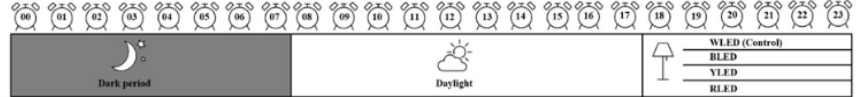
exposed to white LED light (400–740 nm), representing today’s human home environment. BLED: